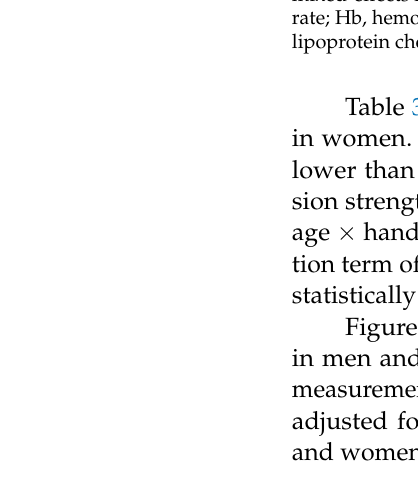
Table 3. Linear mixed-effects model of the association between age and measures of physical function and the interaction effects in